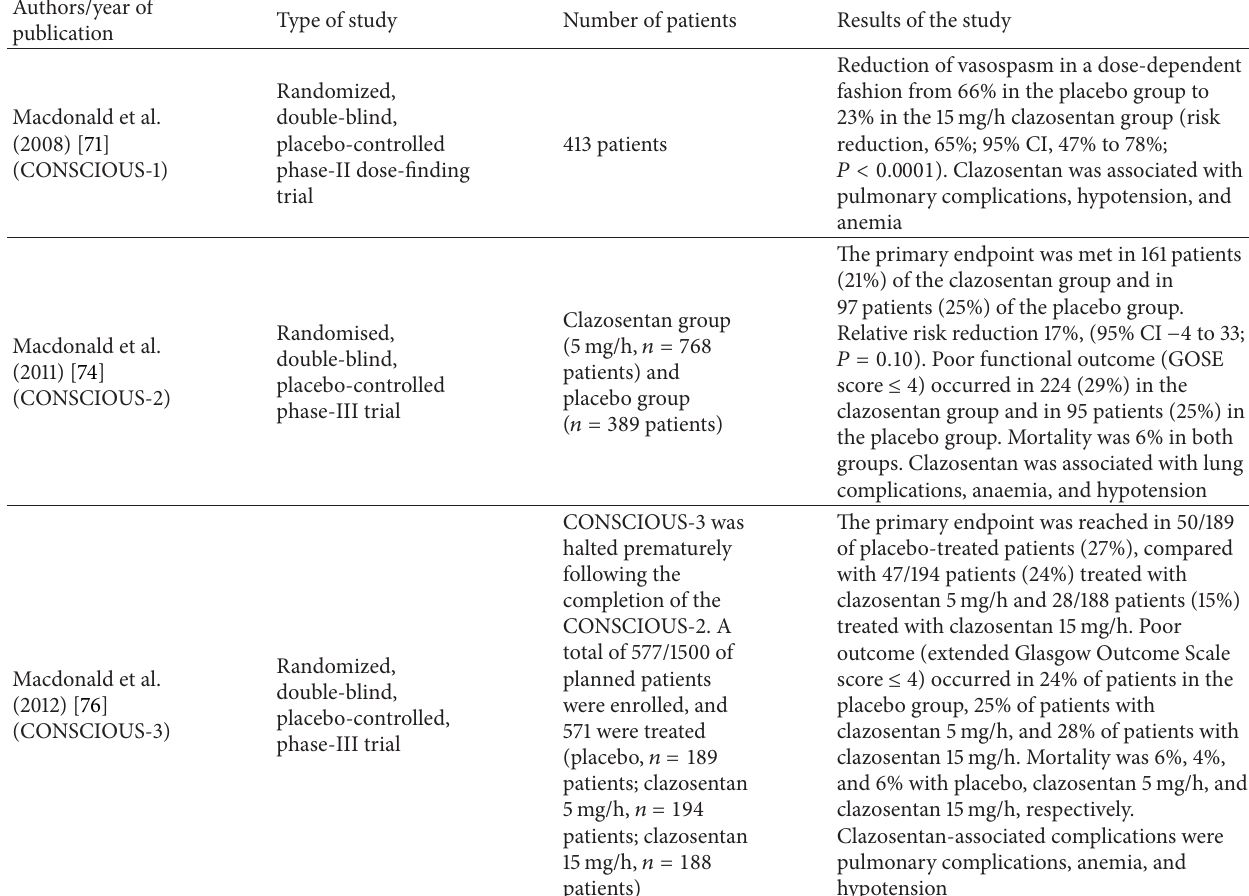
Table 1: Summary of clinical data regarding ET-1 antagonists in managing cerebral